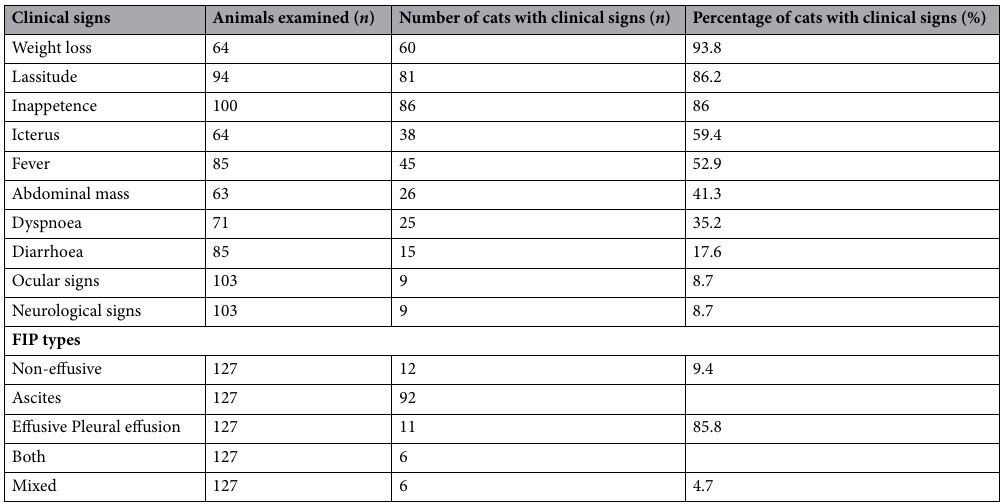
Table 2. Clinical signs of cats highly suspected of FIP. Ocular signs included uveitis, corneal oedema, hyphema, anisocoria, and retinal detachment. Neurological signs included ataxia, paralysis of the hind limbs, nystagmus, twitching, and salivation. Data were given as n.